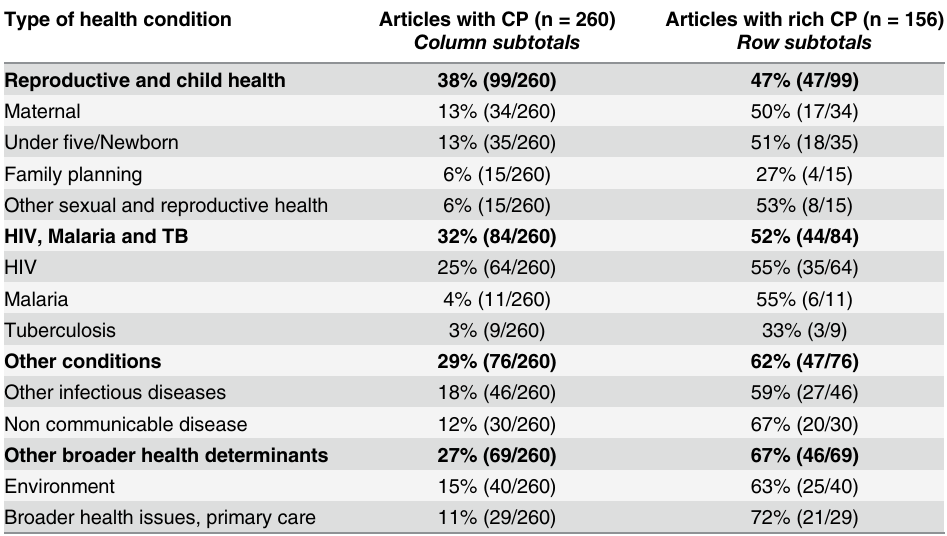
Table 8. Extent of community participation across health